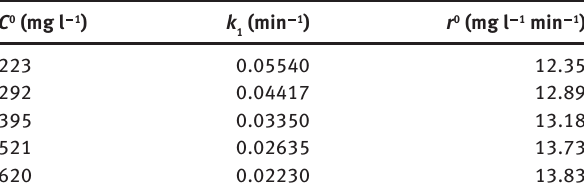
Table 2: First-order kinetic parameters of the catalytic oxidation of DBT at different initial DBT concentrations.